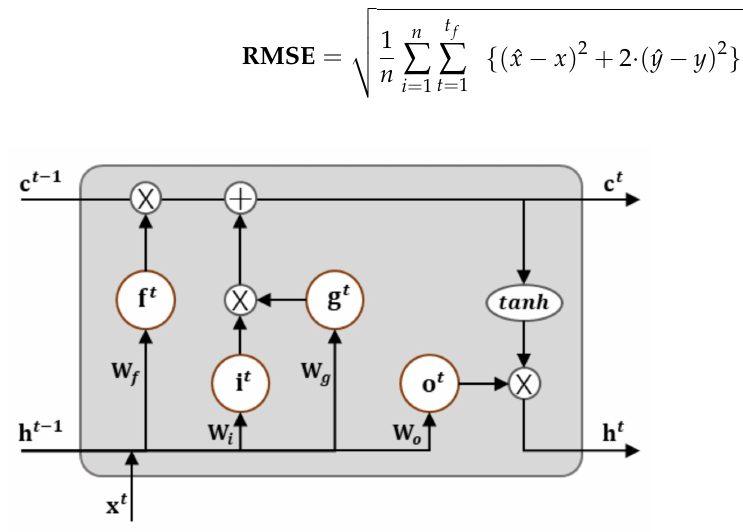
Figure 4. The structure of an LSTM